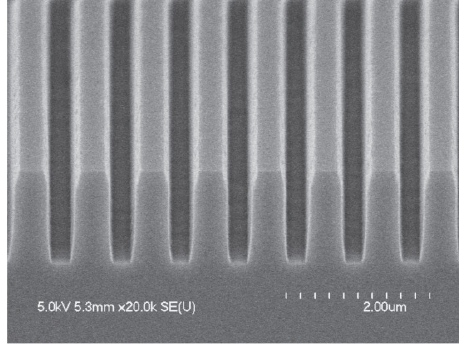
Figure 32. Representative SEM image of the transmission grating.